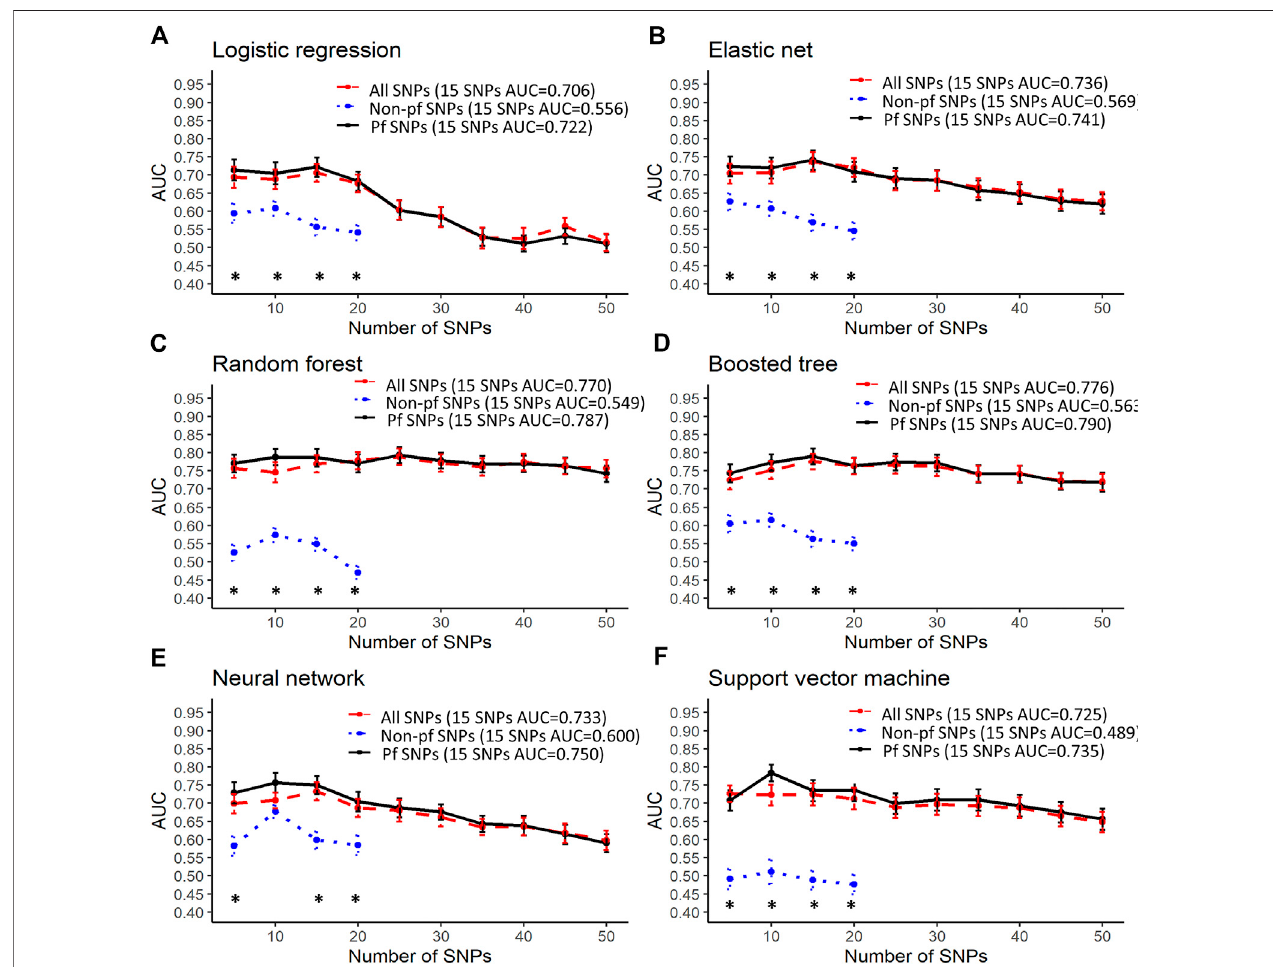
FIGURE 4 | Predictive performance using the top 5 – 50 SNPs in genes found to be associated with myalgia from previous studies. Error bars denote the standard error of the mean. # ’ s indicate statistical signi fi cance when comparing between all SNPs and pfSNPs while * ’ s indicate statistical signi fi cance when comparing between non-pf SNPs and pfSNPs. Statistical signi fi cance when comparing between all SNPs and non-pfSNPs is not shown. The colors represent the input set with the higher AUC (red — all SNPs, blue — non-pf SNPs and black — pfSNPs). Bonferroni corrected unpaired t -test p -values ( p < 0.05) were used for determining statistical signi fi cance. Only 20 non-pf SNPs were found in genes associated with myalgia from the literature.